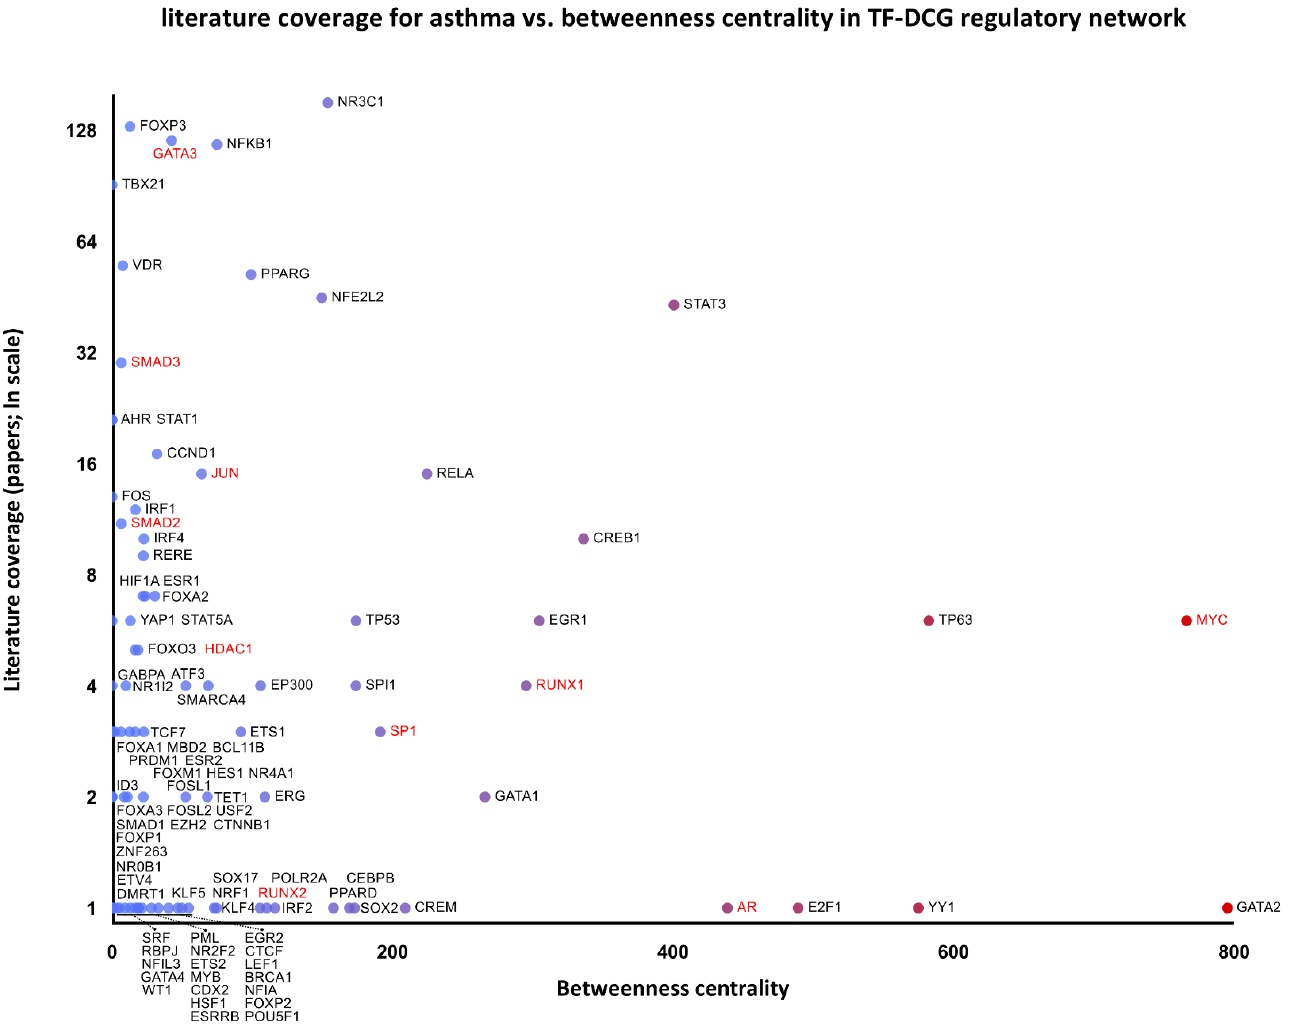
Figure 3. Literature coverage for asthma against betweenness centrality of the transcription factors– differentially co-expressed genes (TF-DCG) regulatory network. Transcription factors combined from networks are included in Supplementary Figures S1–S3. Genes labeled in red form the SMAD2/3 signaling pathway.